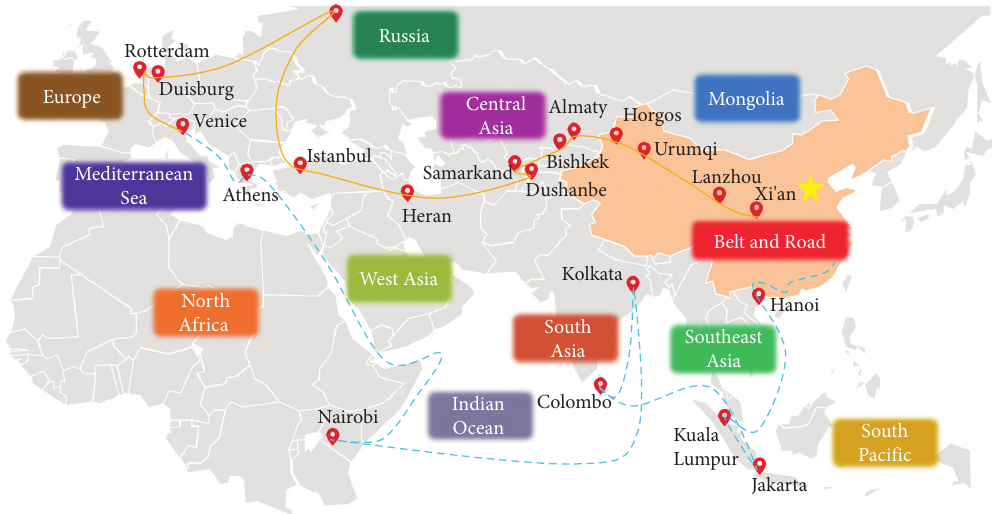
Figure 1: The Belt and Road Initiative roadmap.